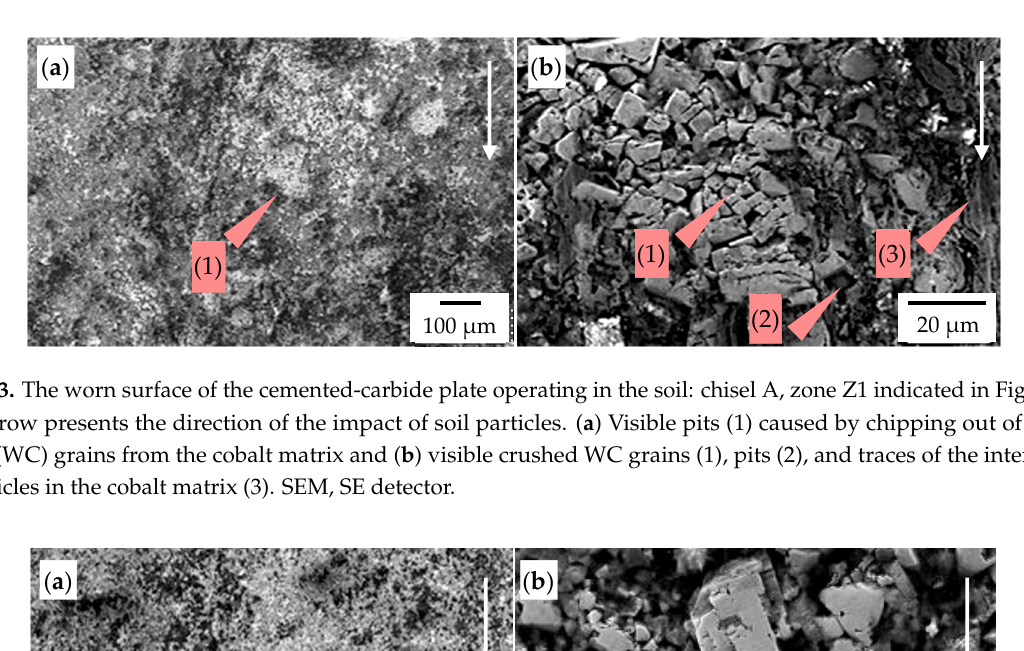
Figure 15 . The worn surface of the cemented-carbide plate operating in the soil: chisel B, zone Z3 indicated in Figure 5; the white arrow presents the direction of the impact of soil. ( a ) Visible traces of the interaction of soil particles in the cobalt matrix (grinding effect) (1) and pits (2) and ( b ) visible WC grains poorly embedded in the cobalt matrix (1), which was removed. SEM, SE detector.